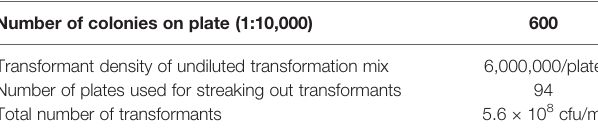
TABLE 2 | Calculation of the transformation ef fi ciency of the cDNA library.